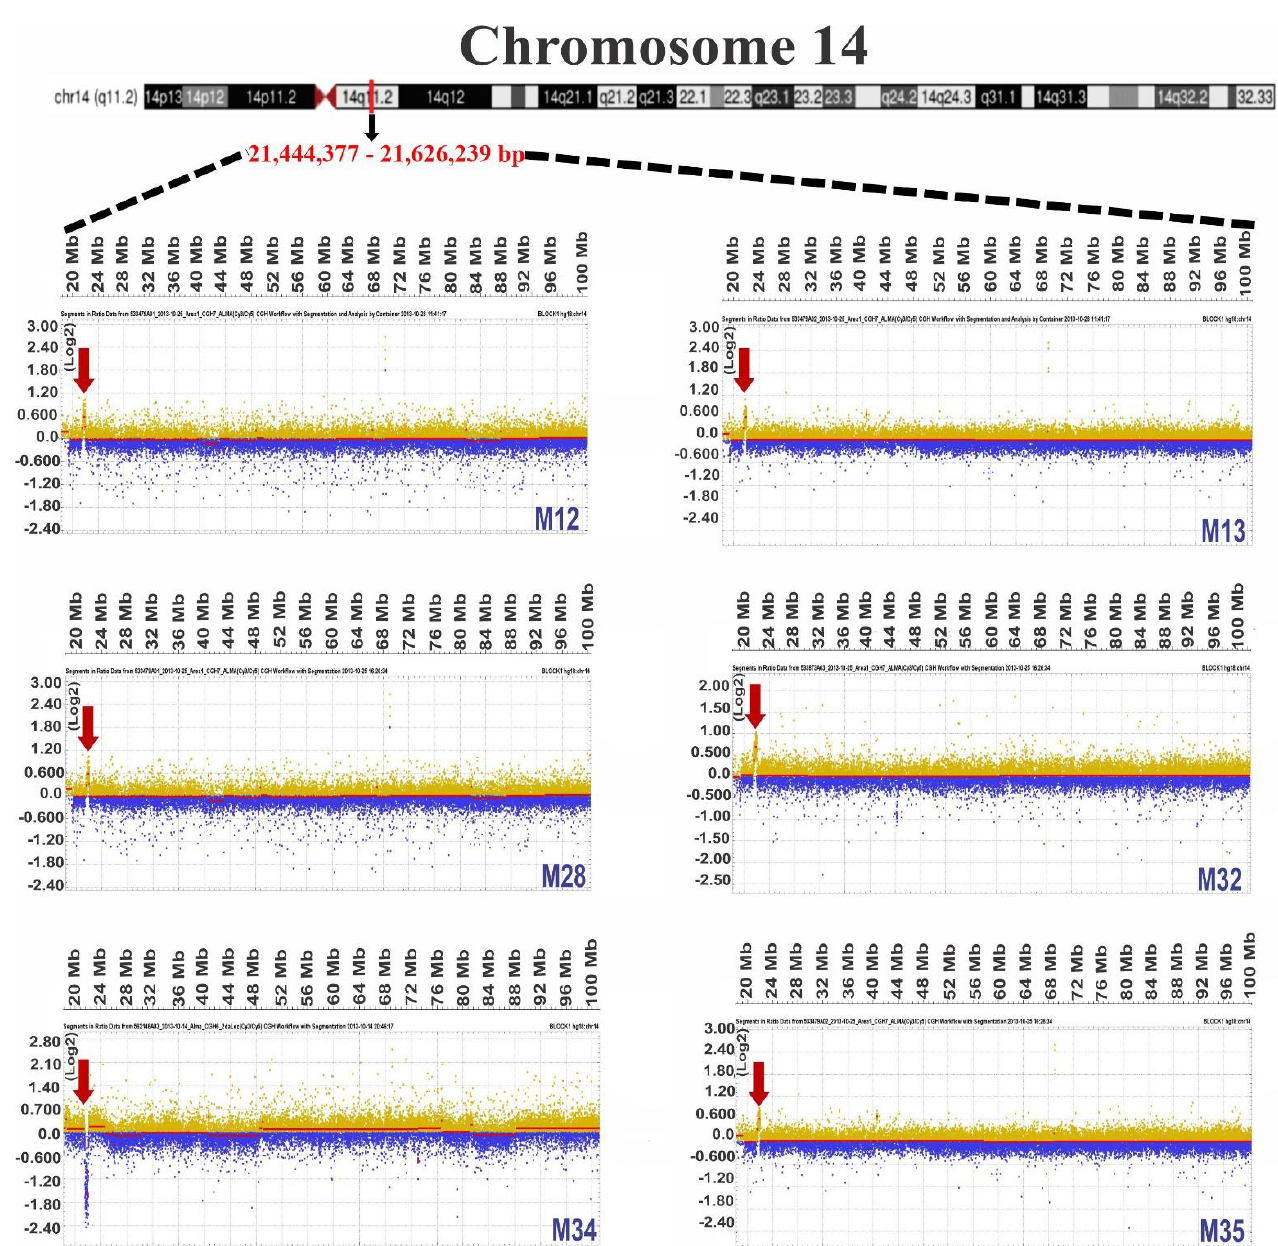
Figure 1. Comparative genomic hybridization images of gains observed for chromosome 14. The ideogram for chromosome 14 shows the common gain region on the q11.2 arm with dotted lines. Representative images of each patient or cell line were obtained with DEVA software; gains are indicated by red arrows, and signal intensity values (ratios) were normalized to Log2. The size scale is shown in megabases (Mb). The patient ID is included in the lower-right margin of each image.